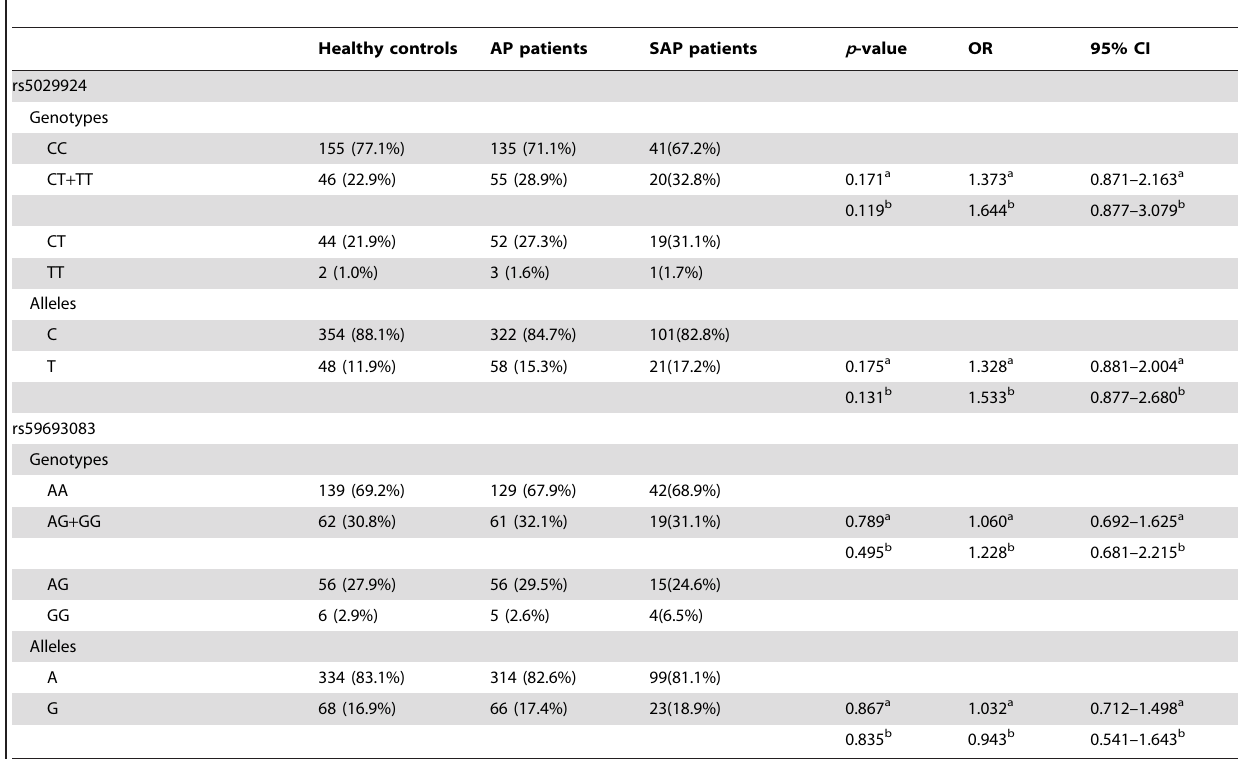
Table 2. Genotype and allele frequencies of variants in the TNFAIP3 promoter in healthy controls and AP patients.